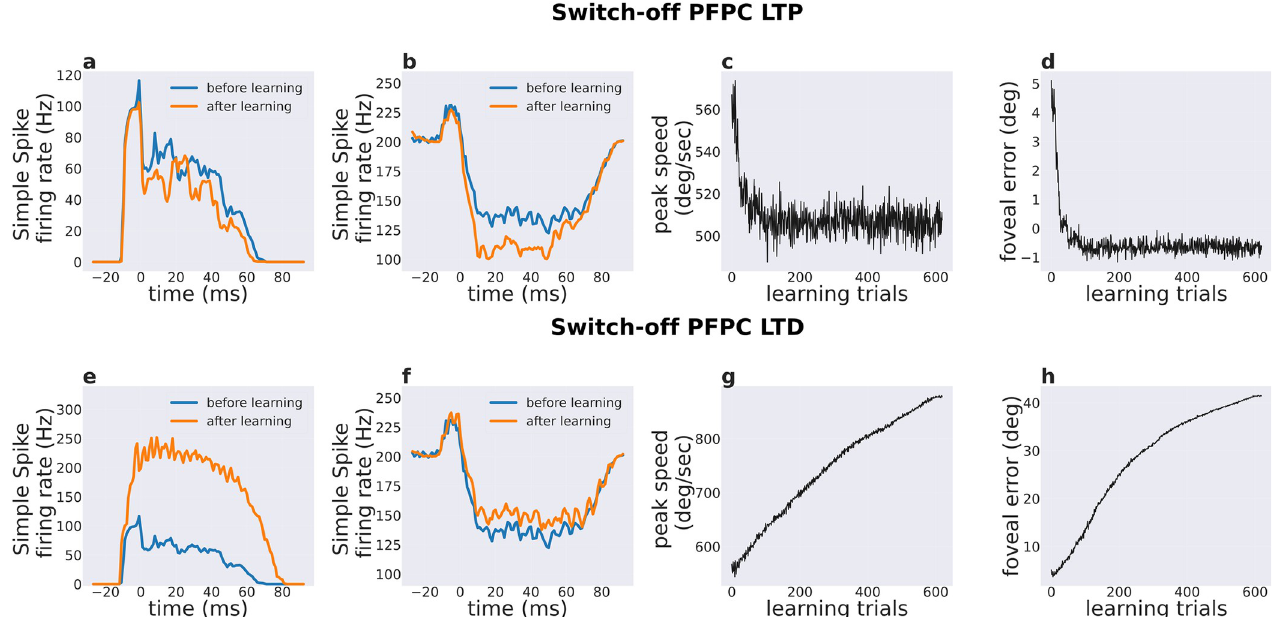
Fig 5. Effect of selective switch-off of plasticity (LTP or LTD) on PC population activity and saccade kinematics. Simple spike activity before and after training when switching-off LTP or LTD. in a,e) the burst PC subpopulation and in b, f) the pause PC subpopulation. c, g) Peak eye speed across learning trials when switching-off LTP or LTD. d, h) Foveal error across training trials by switching-off LTP or LTD.